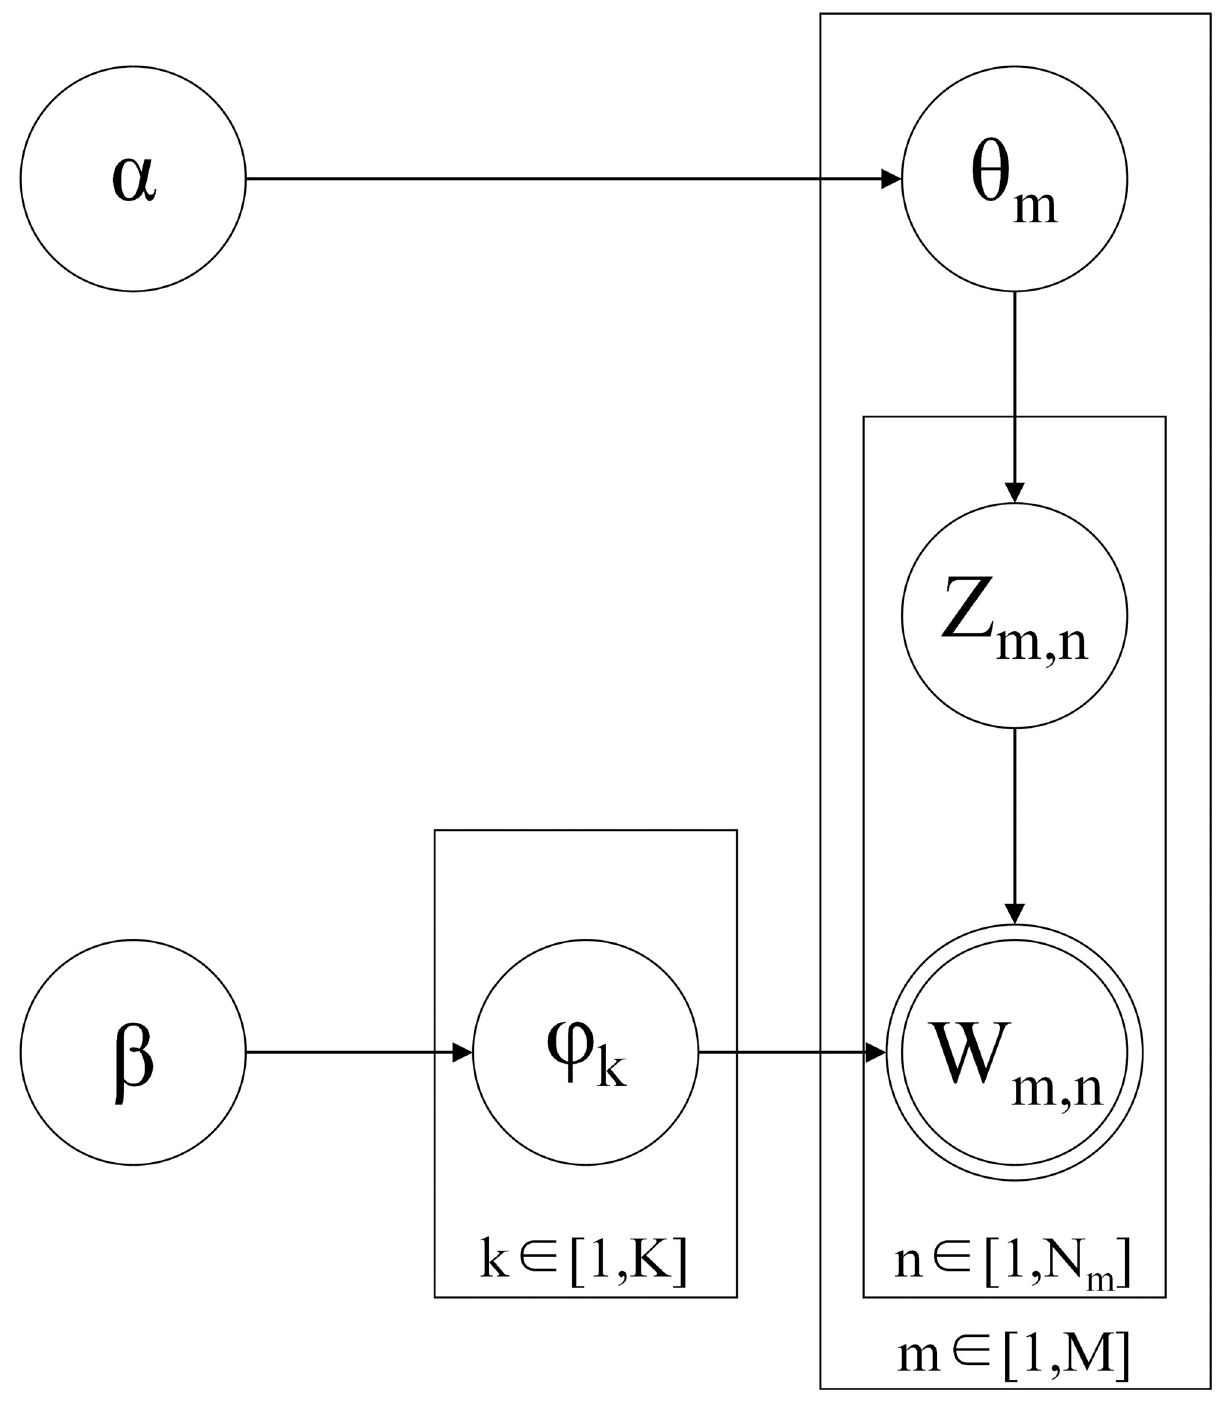
Fig 3. Topic generation process of the LDA model. Adopted from Blei et al. [22].